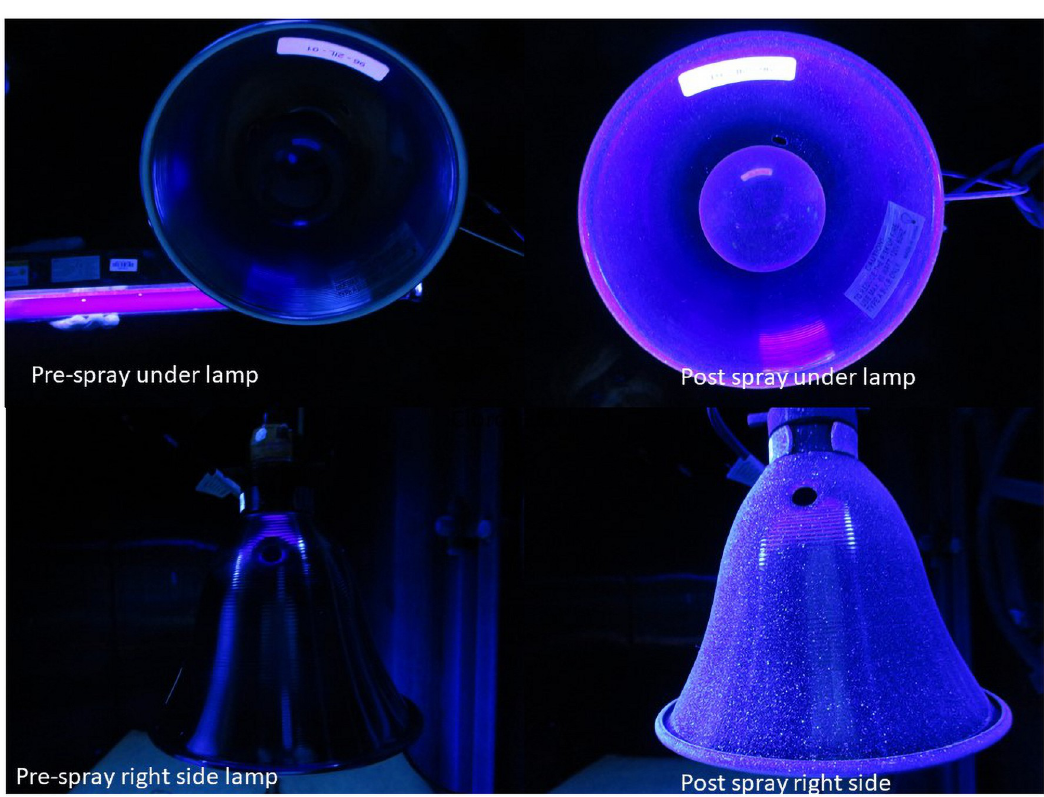
Fig 5. Example photographs of a clip-on lamp, before and after spraying fluorescent dye solution.